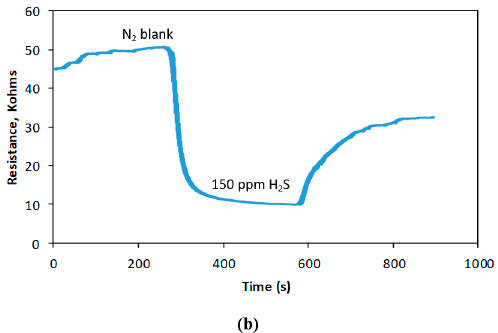
Figure 8. Dynamic response and recovery characteristics of ( a ) PI/AuNPs, and ( b ) PANI/AuNPs-based chemiresistor sensors towards 150 ppm H 2 S at RT (cycle = 1).